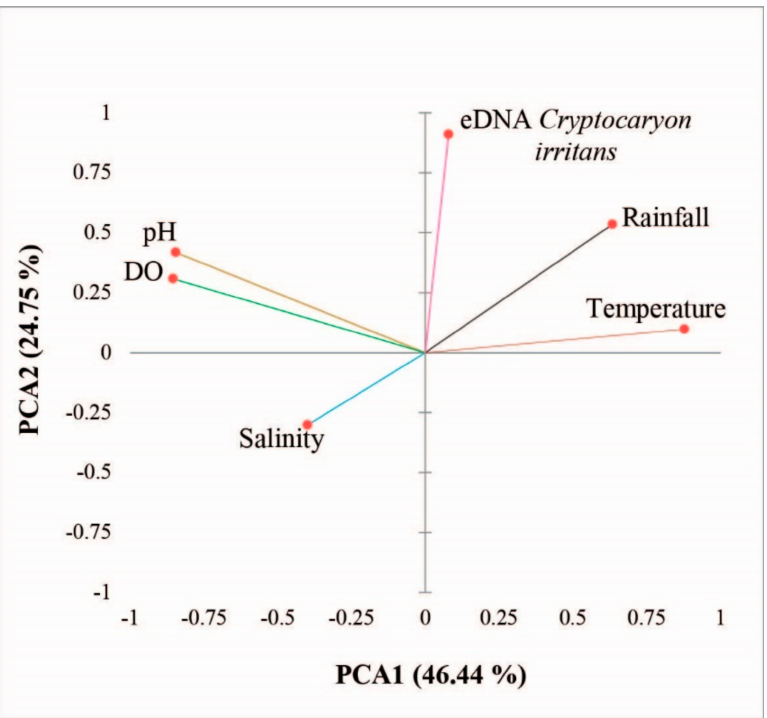
Figure 2. Two most important components of principal component analysis (PCA), showing rela- tionship among variables: abundance of Cryptocaryon irritans water (eDNA), rainfall, temperature, dissolved oxygen, pH, and salinity for five fish sea cages between January and August 2020 from Hong